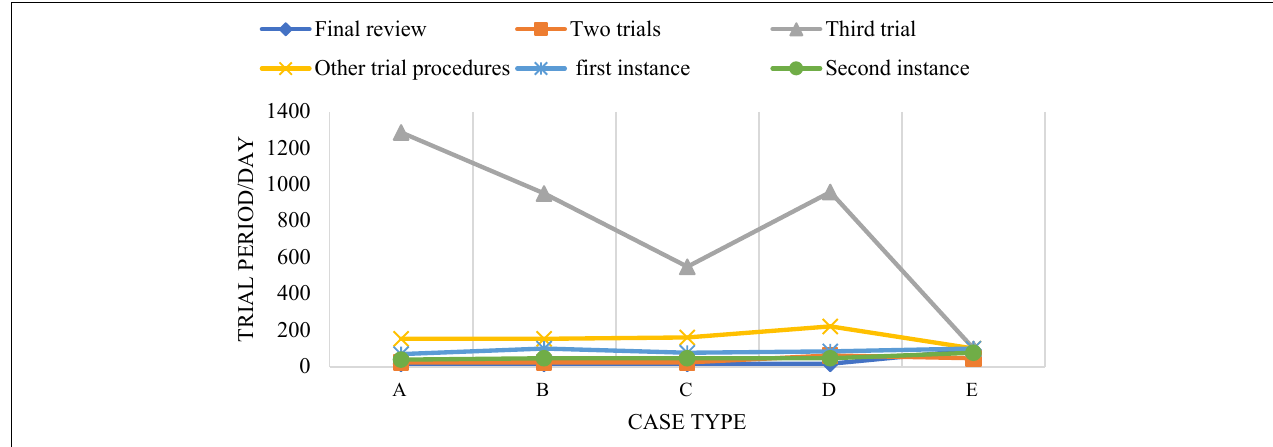
FIGURE 11 | Distribution of trial cycles of different types of cases. (A: Intellectual property plagiarism, infringement dispute; B: other intellectual property competition disputes; C: intellectual property contract dispute; D: unfair competition dispute; E: monopoly dispute).